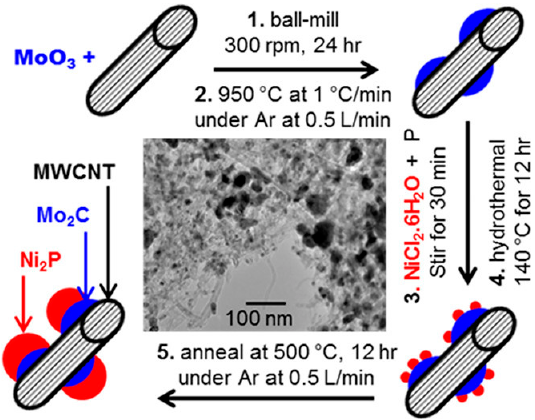
Figure 1. Sequential synthesis scheme for carbide-phosphide composite catalysts. Inset is a TEM micrograph with composite catalysts supported and dispersed on multi-walled carbon nanotubes (MWCNTs). Reprinted with permission from [38]. Copyright American Chemical Society, 2017.